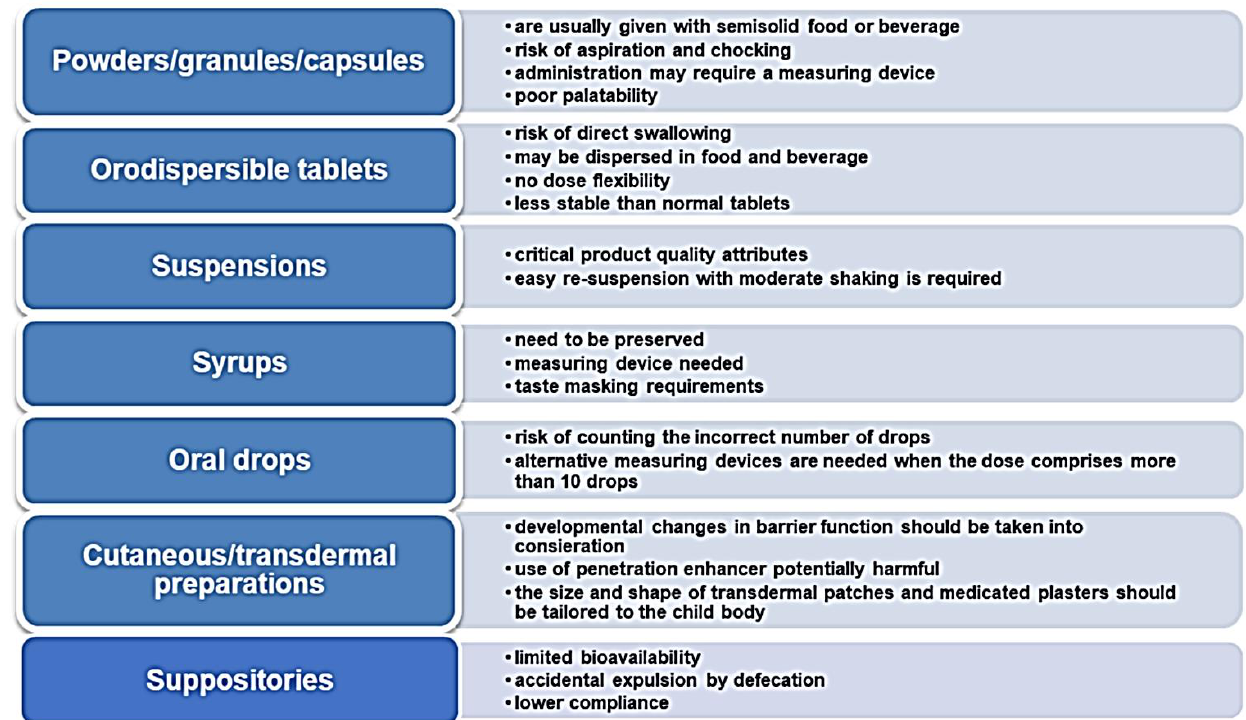
Figure 4. The main usability issues and concerns of common pediatric dosage forms.